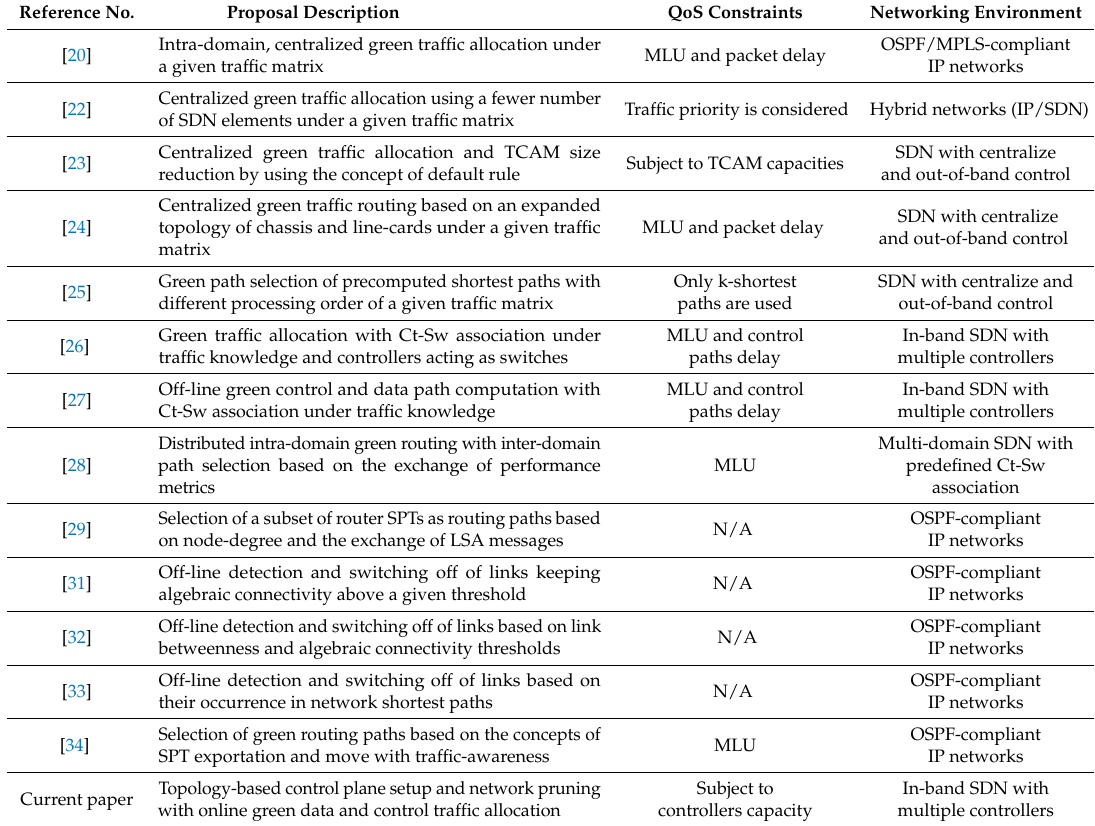
Table 1. Comparison between the proposed approach and other existing related works. MLU, Maximum Link Utilization; OSPF, Open Shortest Path First; MPLS, Multiprotocol Label Switching; TCAM, Ternary Content Addressable Memory; SPT, Shortest Path Tree; LSA, Link State Advertisements. Reference No.